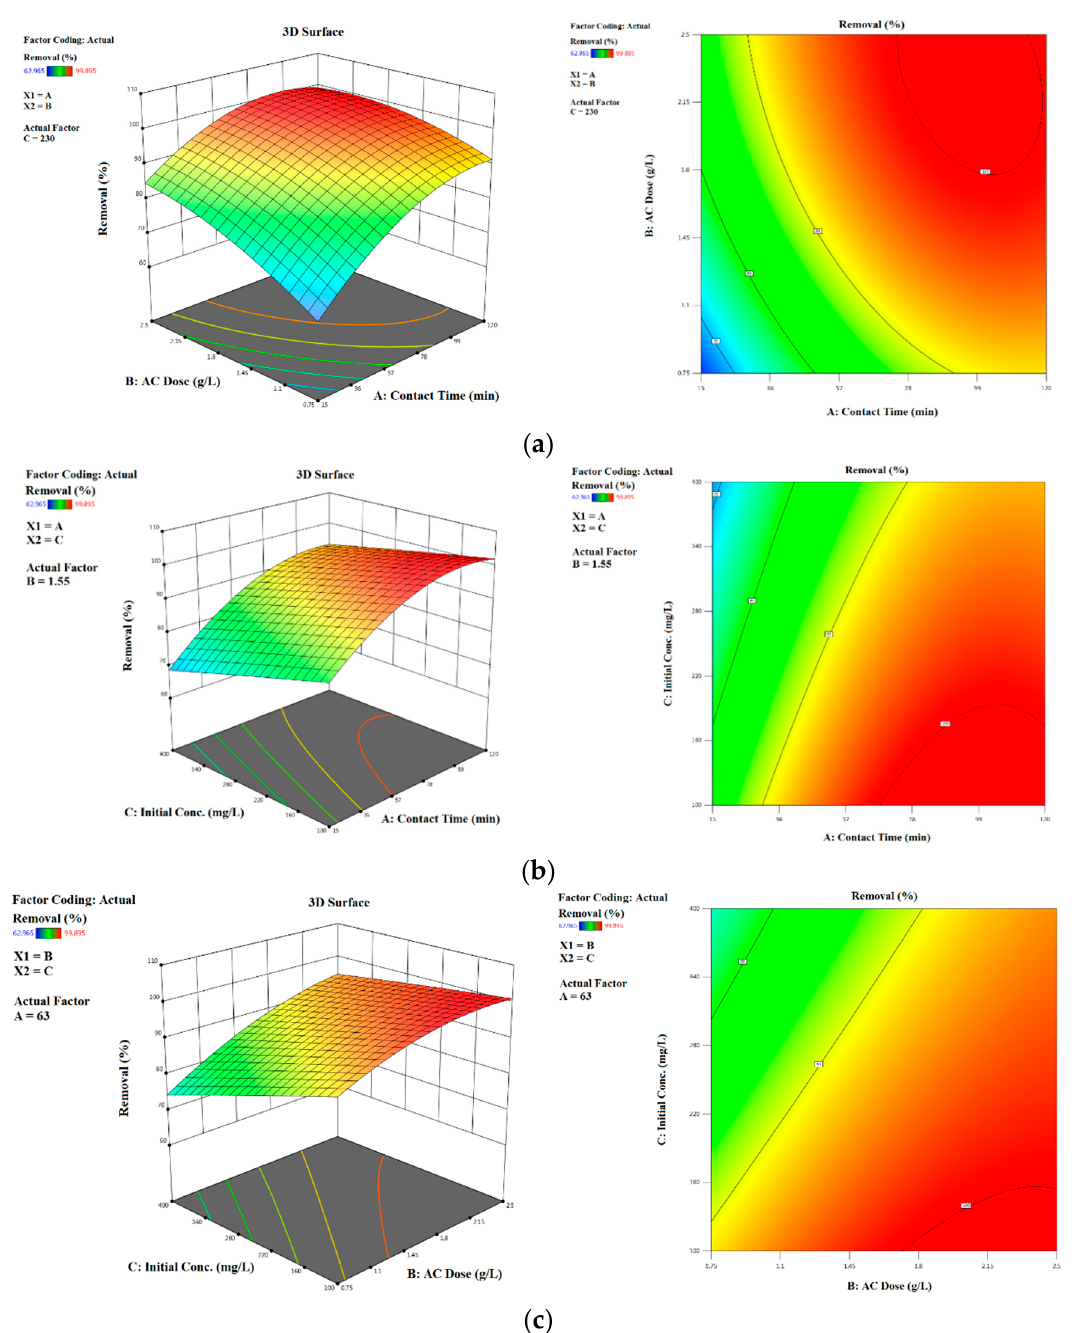
Figure 15. Combined effect of process variables: ( a ) adsorbent dosage and contact time, ( b ) initial concentration and contact time, and ( c ) initial concentration and adsorbent dosage on AO7 dye removal with interaction effect of dual factor.